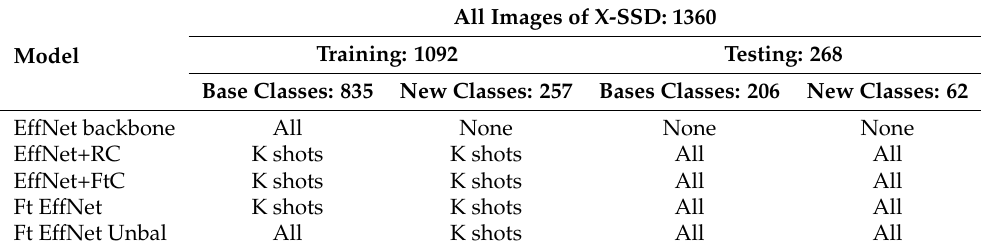
Table 4. The distribution of original X-SSD images in the training and testing datasets for few-shot learning. K is the number of shots in the experiments. The real number of images fed to the network during training is larger due to